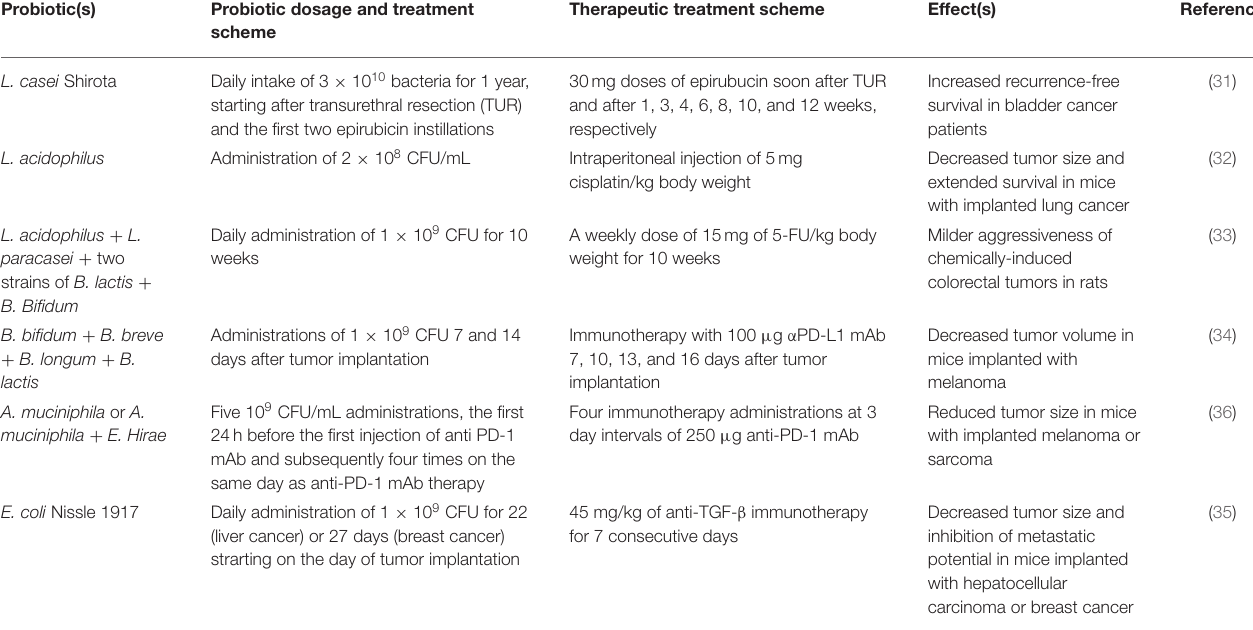
TABLE 1 | Effects of probiotic intake on anticancer therapies’